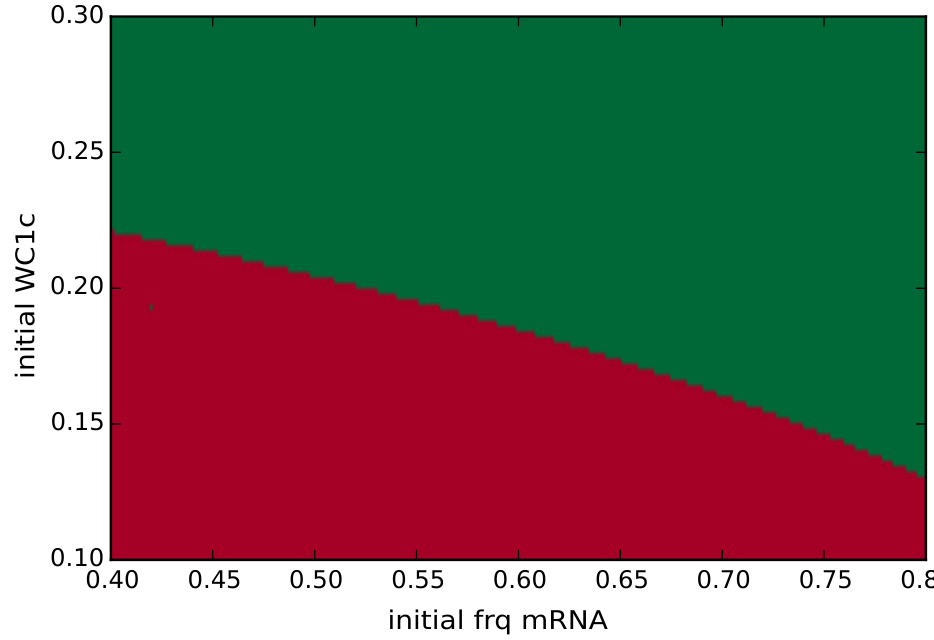
Figure A3. Basins of attractors: Coexisting attractors shown in Figure A2 imply distinct basins of attraction (here, a3 = 3). Small initial values of frq and wc1 (red area) approach the steady state, whereas initial conditions in green approach the limit cycle. The initial conditions of the other variables were